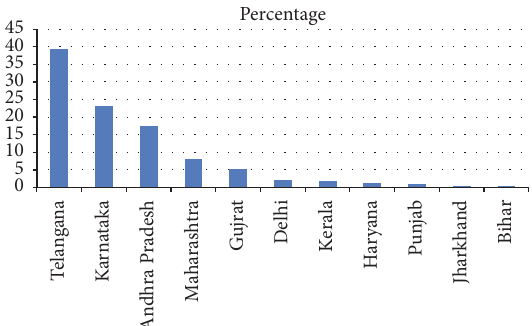
Figure 1: Response rates from different states of India ( 𝑛 = 234